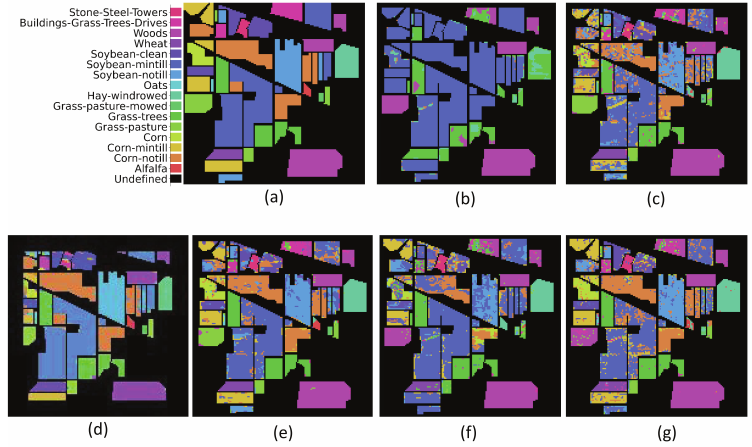
Figure 13. Classification results of Indian Pines: ( a ) ground truth, ( b ) Luo model, ( c ) Li model, ( d ) Hamida model, ( e ) Chen model, ( f ) Hu model, ( g ) proposed